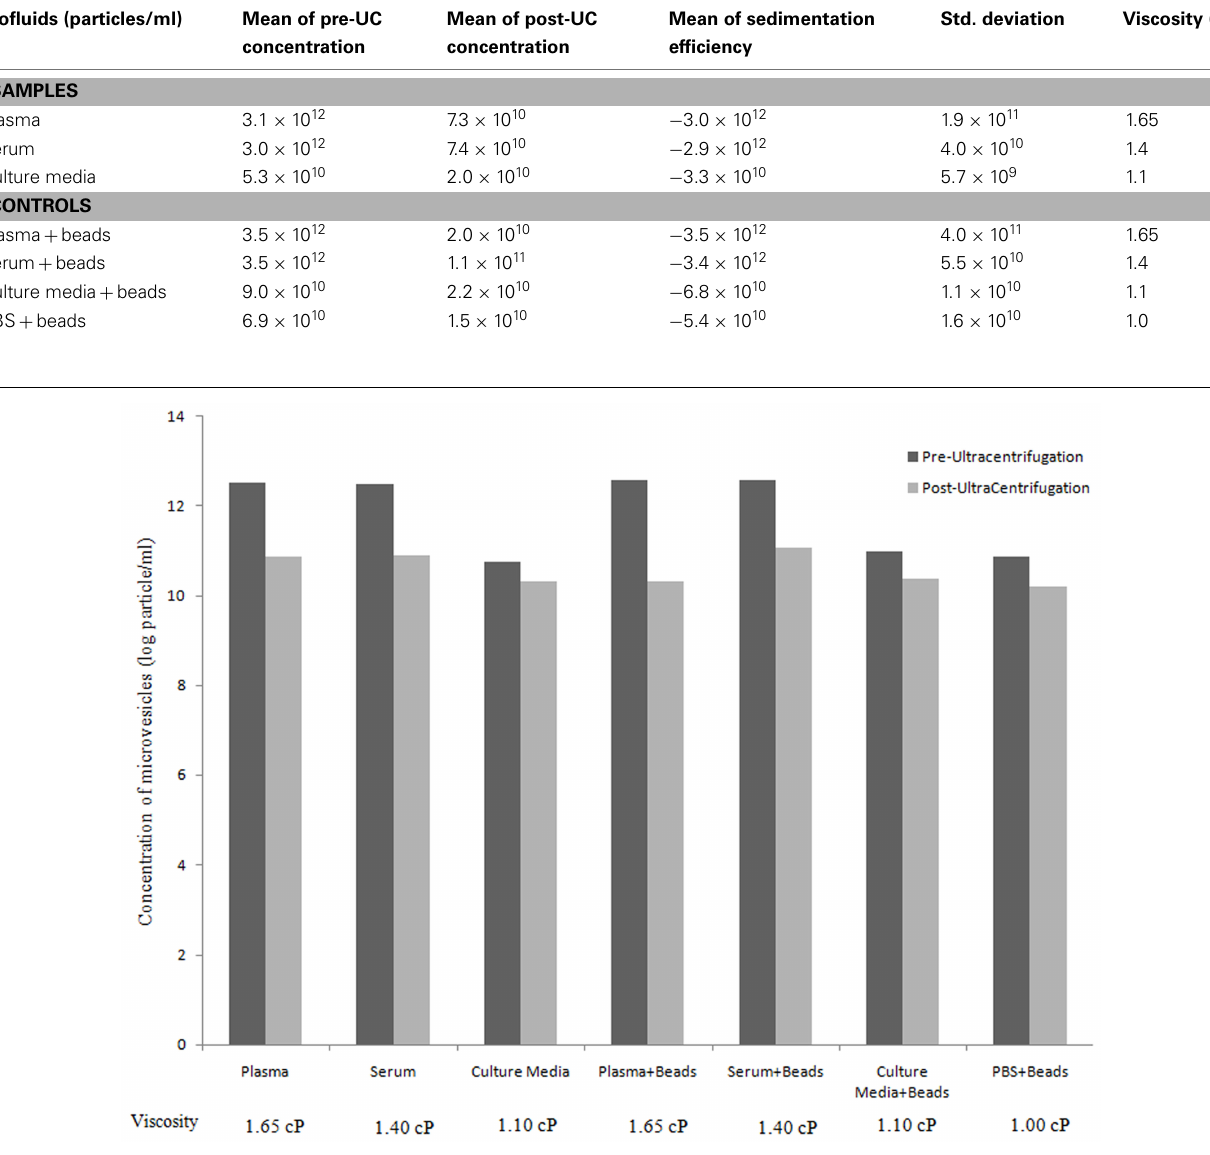
FIGURE 1 |Assessment of microvesicles/microparticles concentration (particles/ml) before and after ultracentrifugation. Bar graph represent the concentration (particles/ml) of MVs/MPs pre-UC (black) and post-UC (gray; Y axis) for different tested samples and controls ( X axis) along with viscosity of each fluid